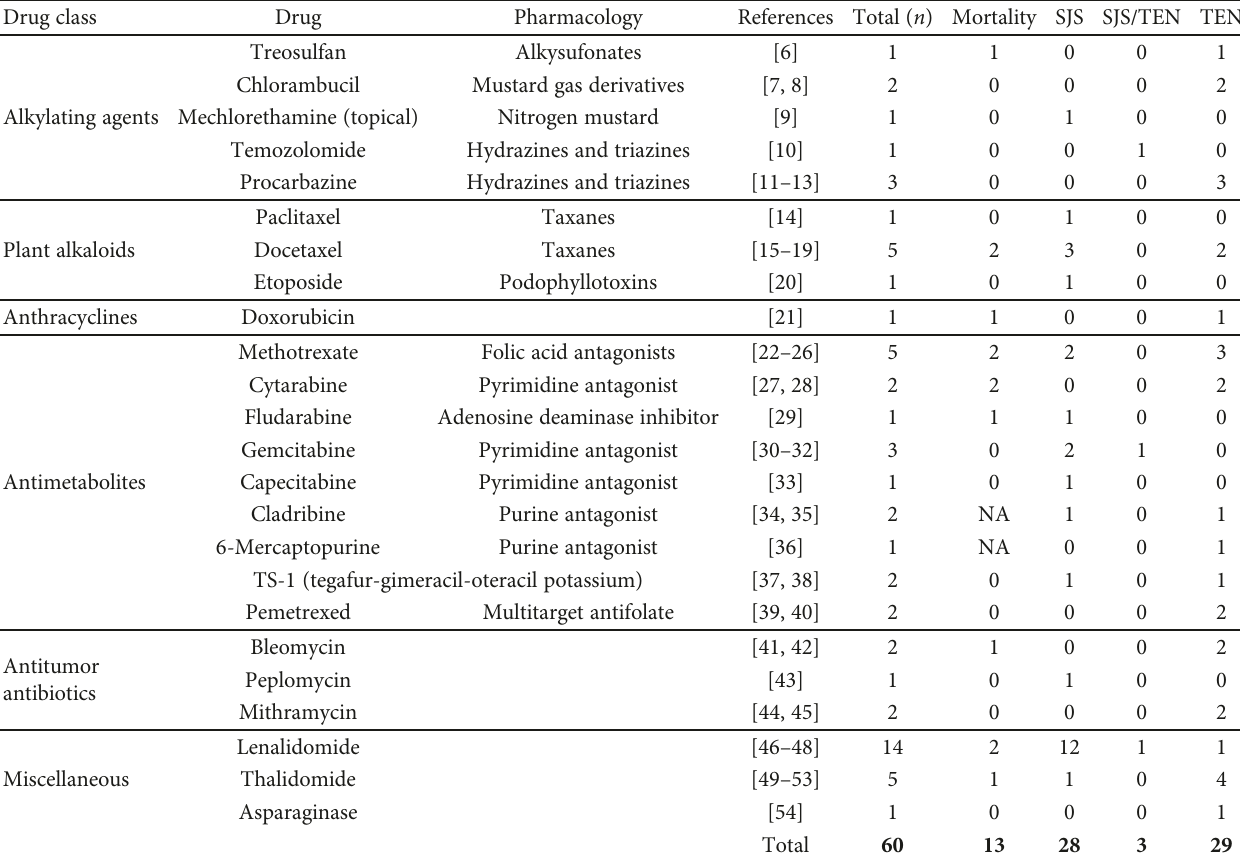
Table 1: Anticancer chemotherapy-related severe cutaneous adverse drug reactions from the English literature (year: 1950 –